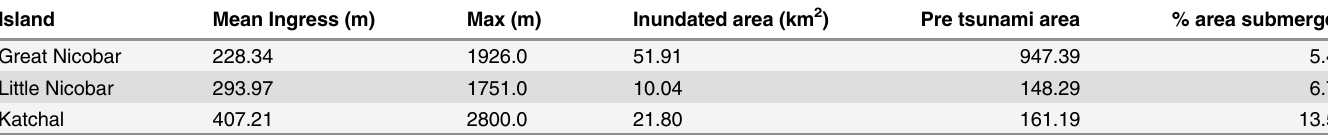
Table 5. Coast line variation after 2004 December tsunami in Nicobar Islands.